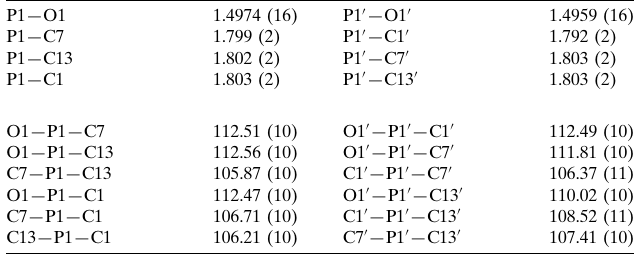
Selected geometric parameters (A˚ , (cid:2) ).